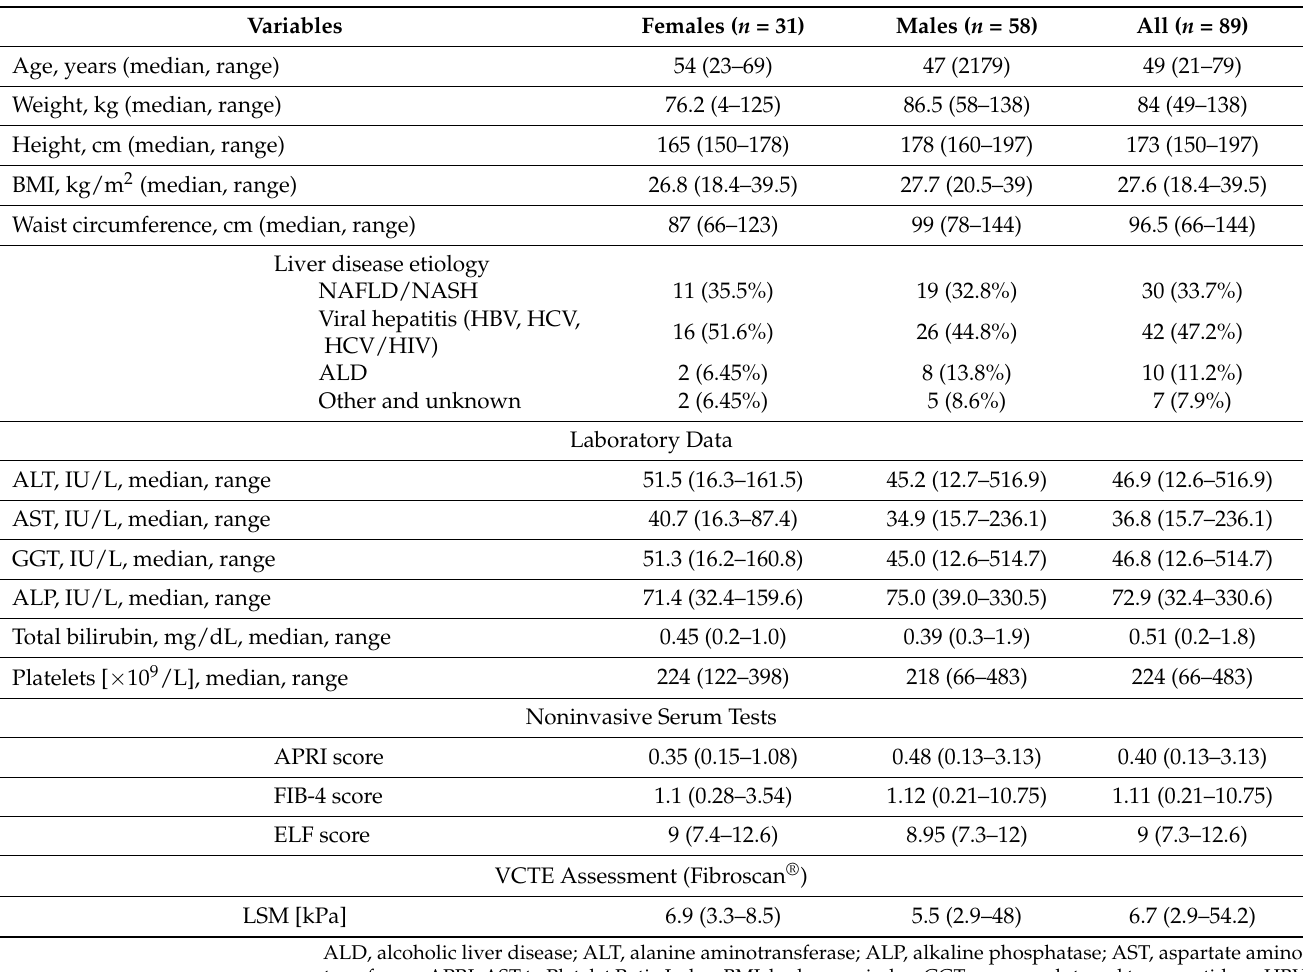
Table 1. Baseline characteristics of the